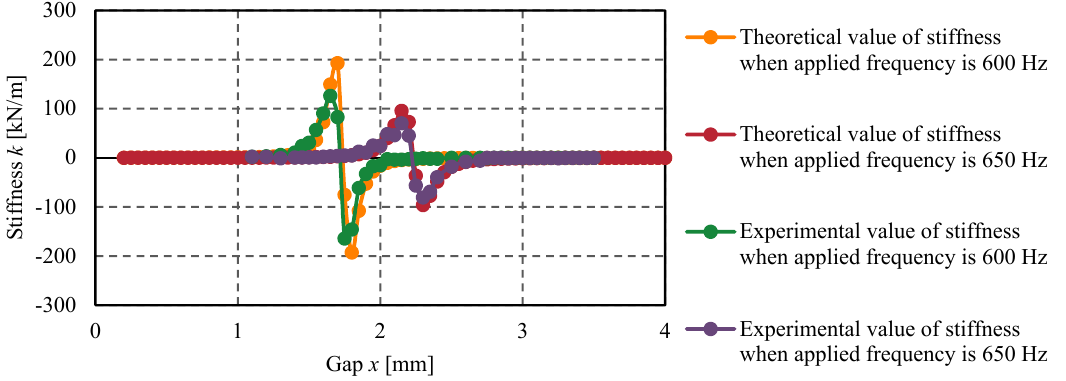
Figure 15. The comparison of the characteristics curve of stiffness when the applied frequency is 600 Hz and 650 Hz.